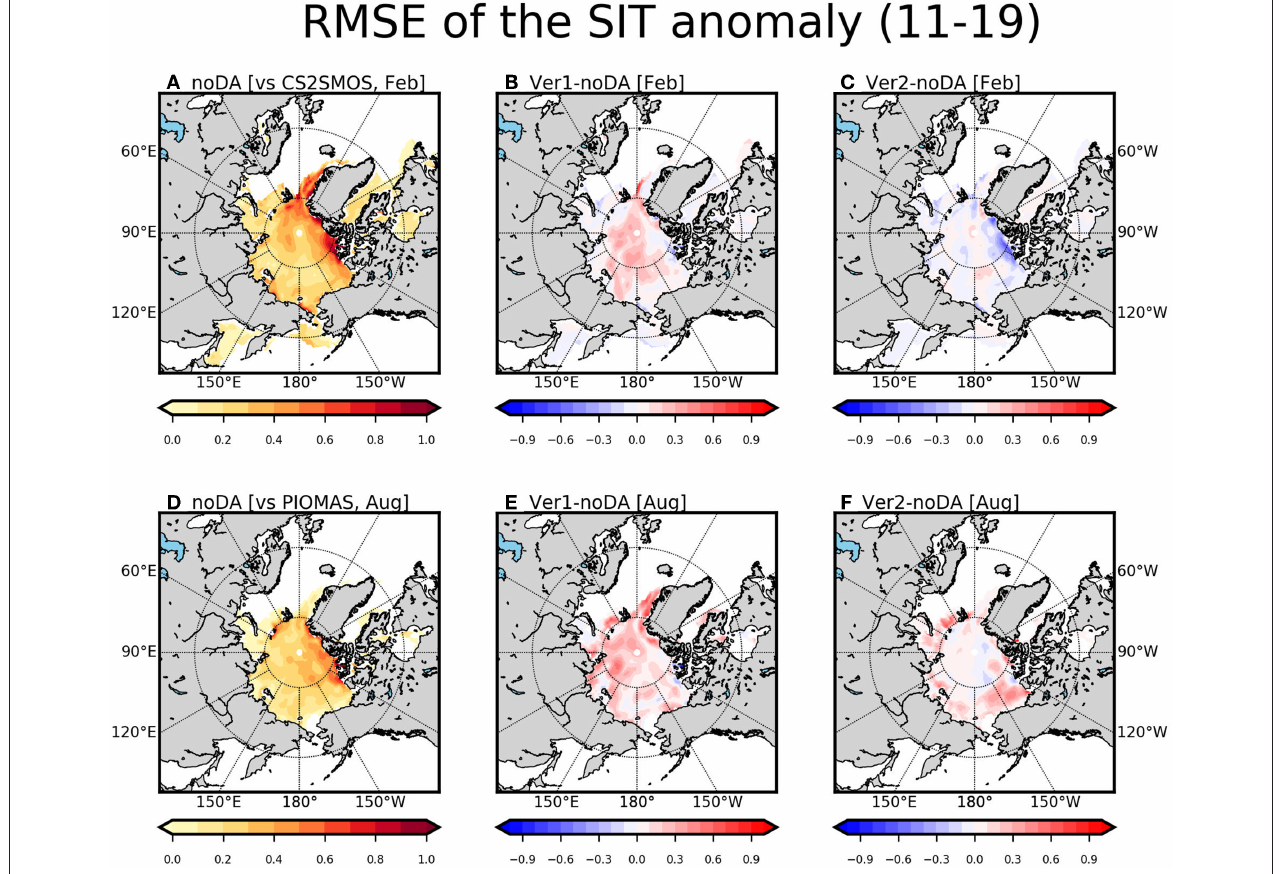
FIGURE 12 | The root-mean-square-errors of sea ice thickness (m) for noDA, Ver1, and Ver2 with respect to the CS2SMOS observation and PIOMAS reanalysis are calculated in February (A–C) and in August (D–F) . Note that the CS2SMOS is used in February and the PIOMAS is used in August due to the absence of satellite data. The RMSE of noDA (A,D) and the difference of Ver1 (B,E) and Ver2 (C,F) with respect to noDA are calculated during 2011–2019.